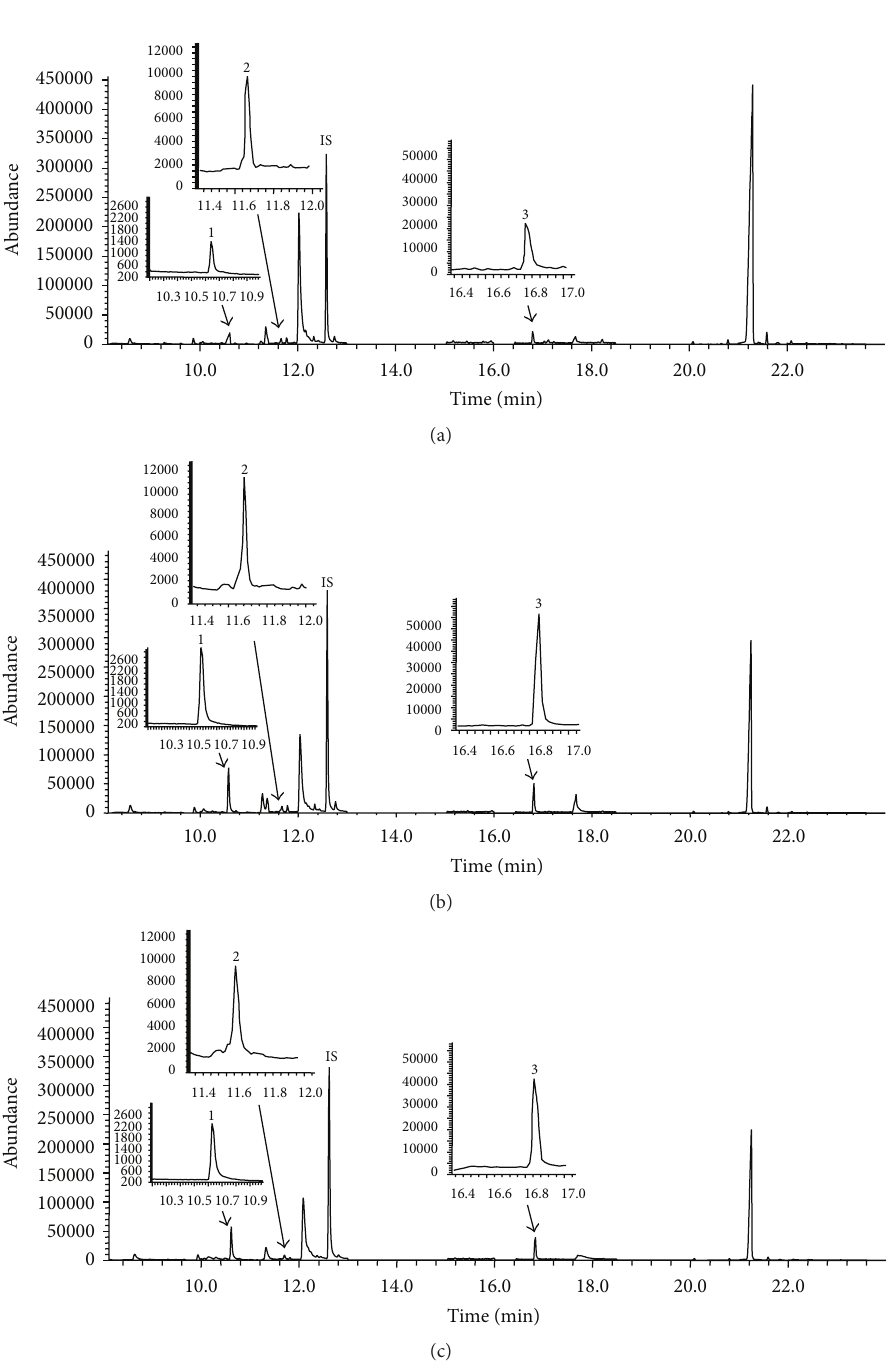
Figure 3: GC-SIM-MS chromatograms of putrescine (1), cadaverine (2), and spermidine (3) in rat brain tissues from control (a), MCAo (b), and MCAo + hBM-MSCs groups (c). IS: internal standard